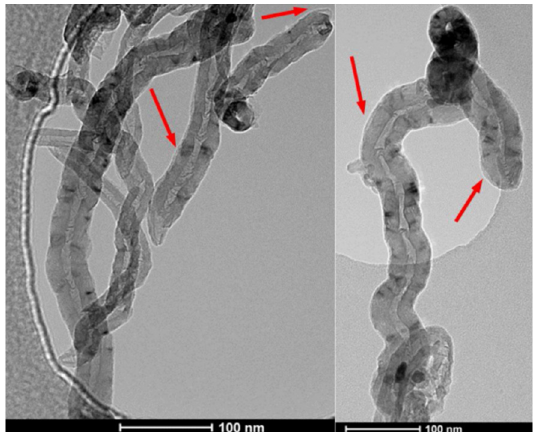
Figure 6. TEM images of multi-walled carbon nanotubes (MWCNTs) nanobiocatalysts. The red arrows indicated unevenly distributed coating by the lipase [96].